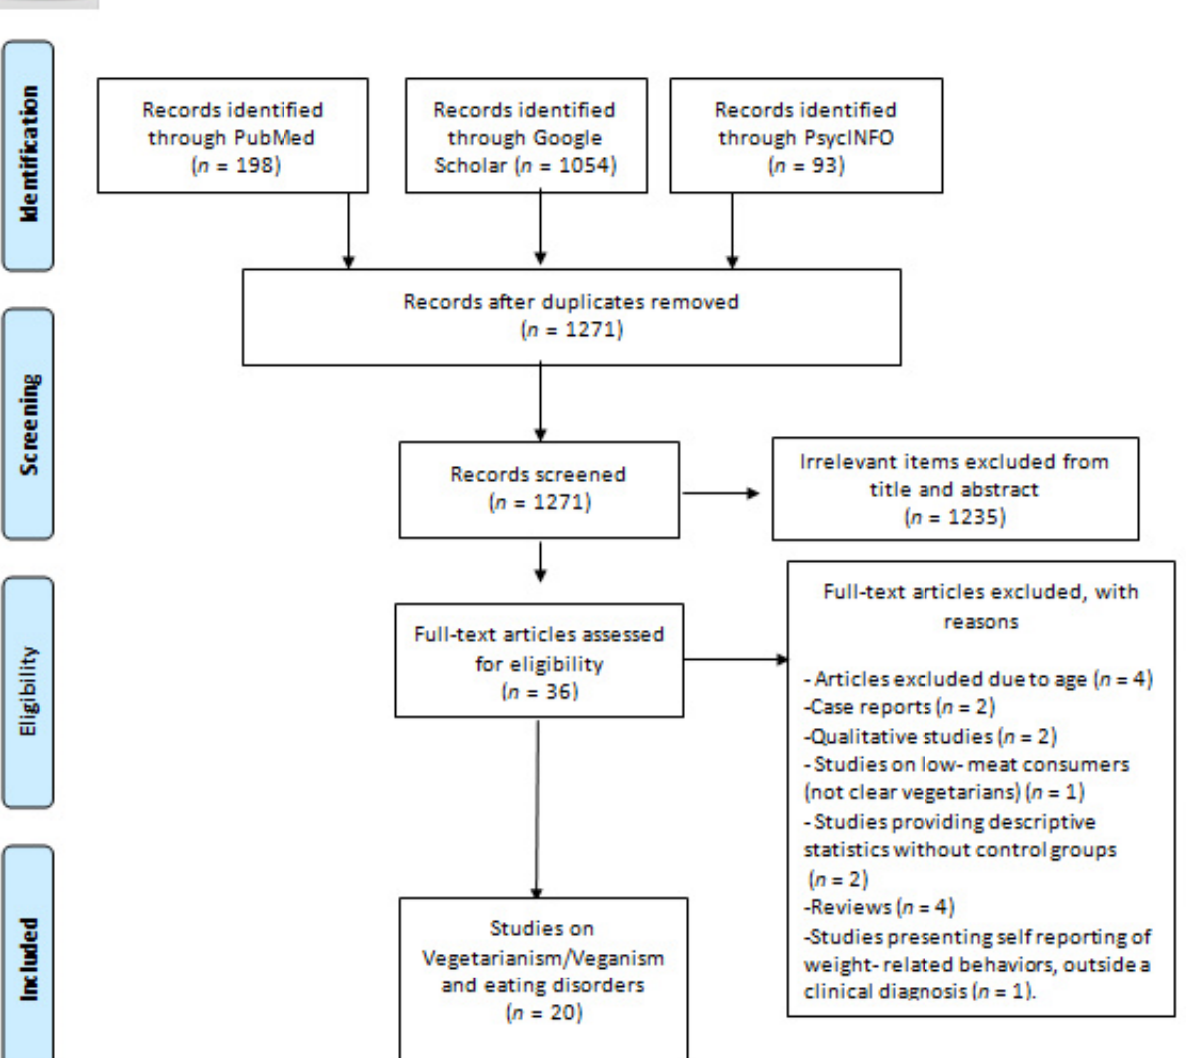
Figure 1. Successive steps in the selection of studies—PRISMA Flow